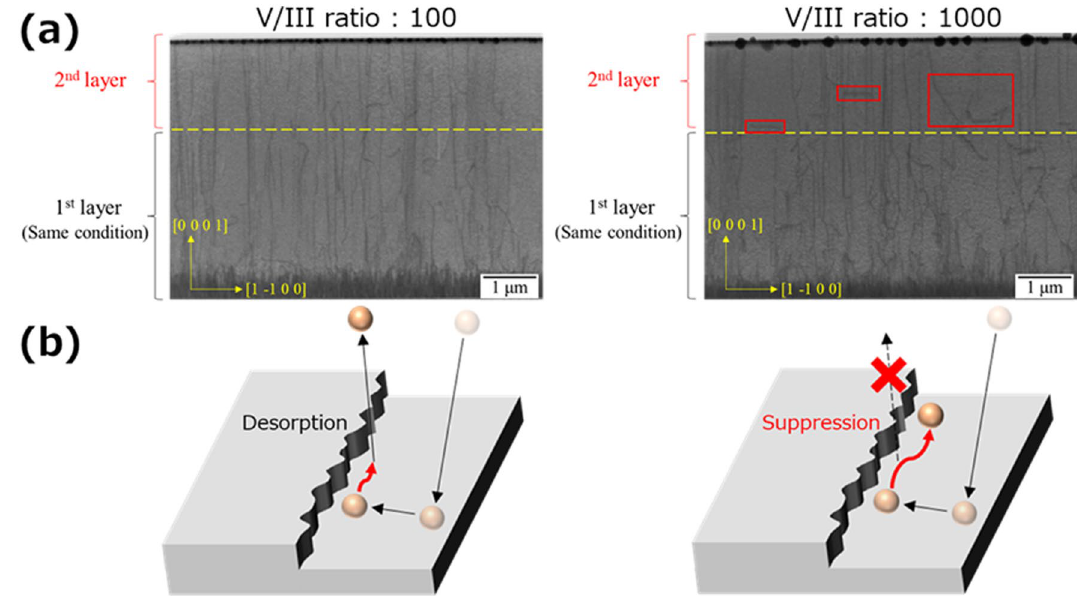
Figure 5. The difference in the behavior of threading dislocations by V/III ratio. ( a ) The measurement of the dislocation densities by field-emission TEM images. The TEM images at both V/III ratios were measured in the same regions. The measurement volume is 6.9 μm × 260 nm × 4.8 μm. The yellow dotted line represents the boundary between the first and second layers. ( b ) Growth models at different V/III